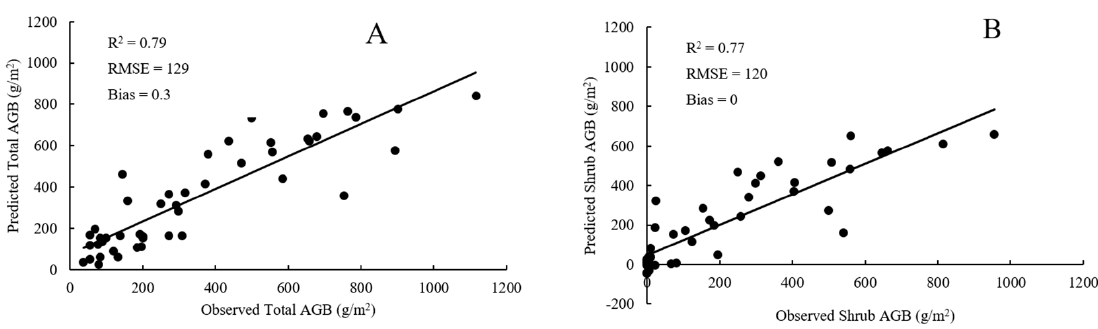
Figure 3. Scatterplots between the observed AGB (field-measured biomass) and the AGB with Equations (2) and (3) for total ( A ) and shrub ( B ) biomass.